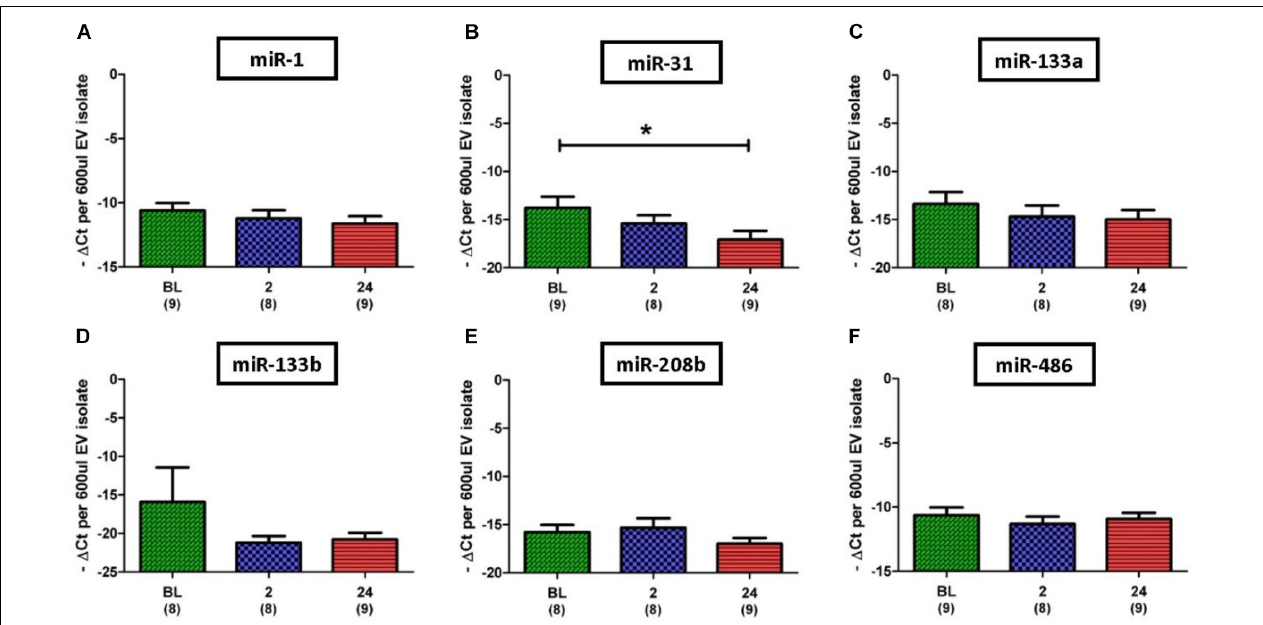
FIGURE 5 | Expression of six EV miR levels normalized to the exogenous control, cel-miR-39. (A,C–F) Relative expression of myomiRs, with no changes noted over time. (B) Decrease in miR-31 at 24 h when compared to BL. Number of subjects for each analysis is noted below the time point. Data are represented as − (cid:49) C t per 600 µ l EV isolate. An arbitrary negative is assigned to each sample so that samples with lower miR content and thus a higher C t will be deemed to have a lower bar graph (one-way ANOVA. Mean ± SEM; ∗ p <